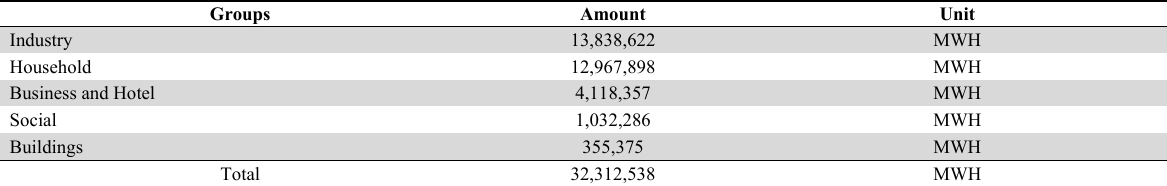
Electric Energy Consumption Based on Tariff